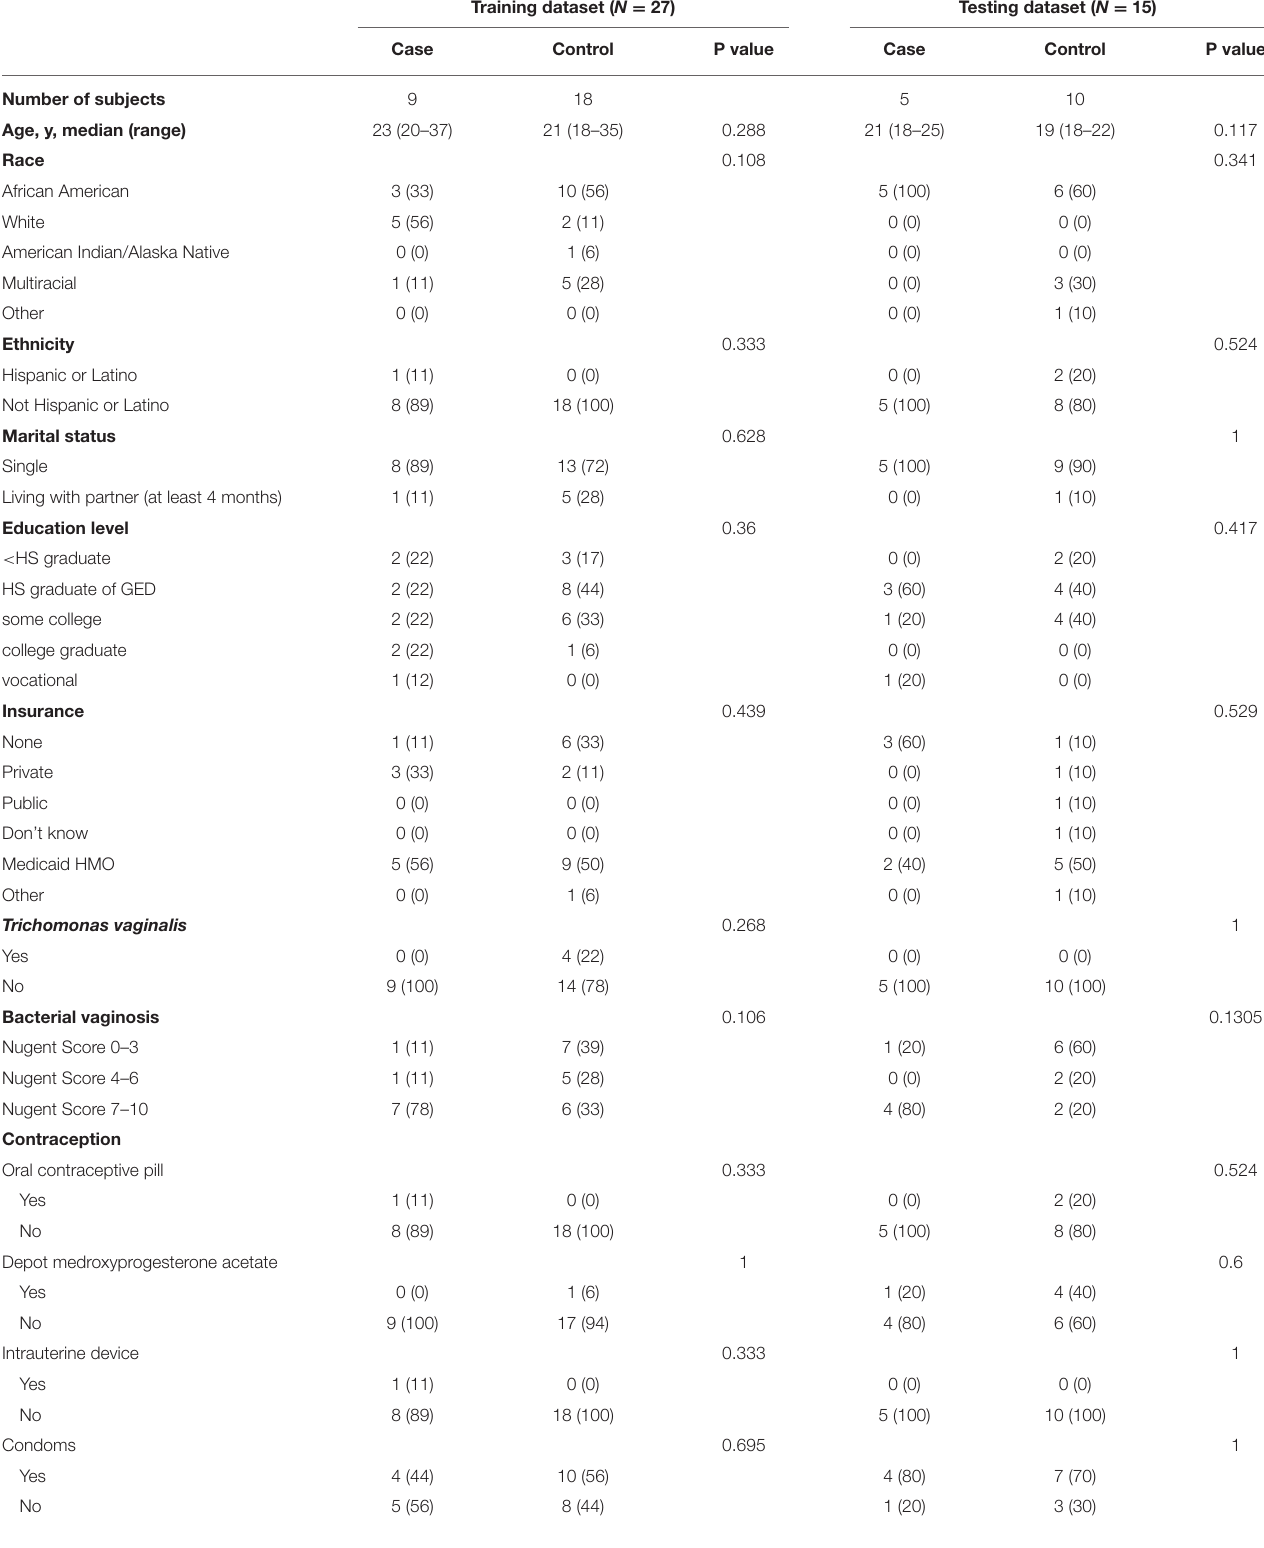
TABLE 1 | Demographic, clinical, and microbiological characteristics of training and testing